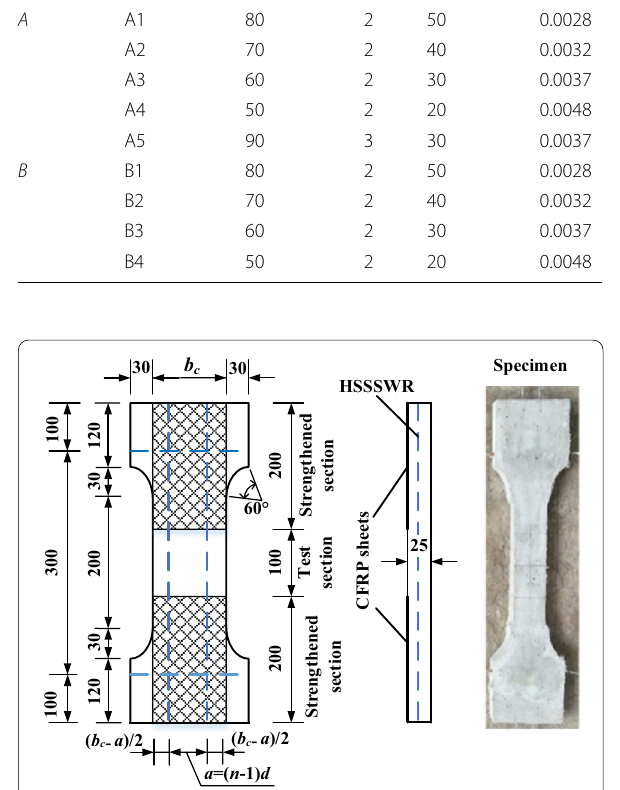
Fig. 1 Dimensions of HSSSWR-reinforced ECC specimens (unit: